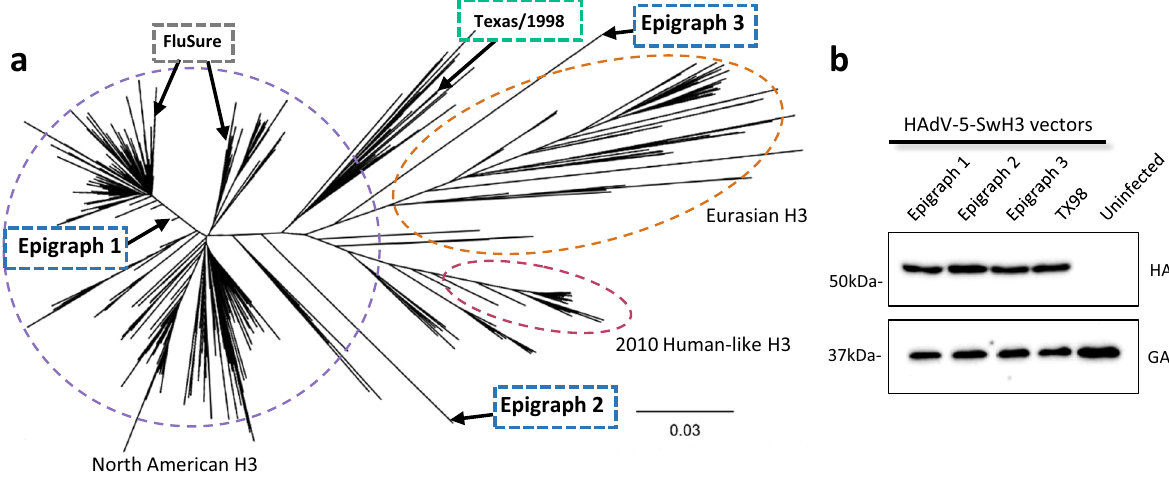
Fig. 1 Characterization of the epigraph vaccine constructs. The three swH3 epigraph immunogens were computationally designed using the Epigraph vaccine designer tool to create a cocktail of immunogens designed to maximize potential epitope coverage in a population. The three epigraph hemagglutinin (HA) immunogens were aligned to the 1561 unique swine H3 HA sequences using a ClustalW alignment. A neighbor-joining tree was constructed to visualize the phylogenic relationship between the vaccine immunogens and the population of swH3 sequences. The three epigraph immunogens, the Texas/1998 (TX98) wild-type HA comparator, and the two FluSure strains are labeled for reference on the phylogenetic tree. The epigraph, wildtype, and FluSure vaccines are shown in the blue, green, and black boxes, respectively. The North American clusters, 2010 human-like lineage, and Eurasian lineage are circled in a dotted line ( a ). All three epigraph immunogens and the TX98 HA were cloned into a replication-defective Adenovirus type 5 (HAdV-5) vector and HA protein expression was con fi rmed by western blot. GAPDH is used as a cellular protein loading control ( b ). Con fi rmation of HA protein expression was obtained from three independent western blot